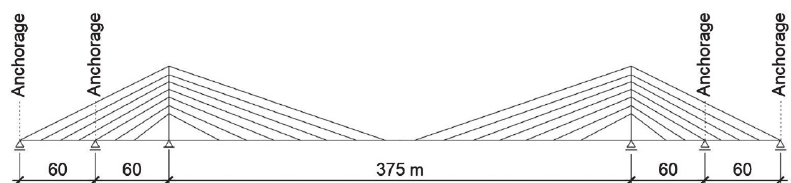
Figure 2. Scheme of the girders in the cable-stayed part of the